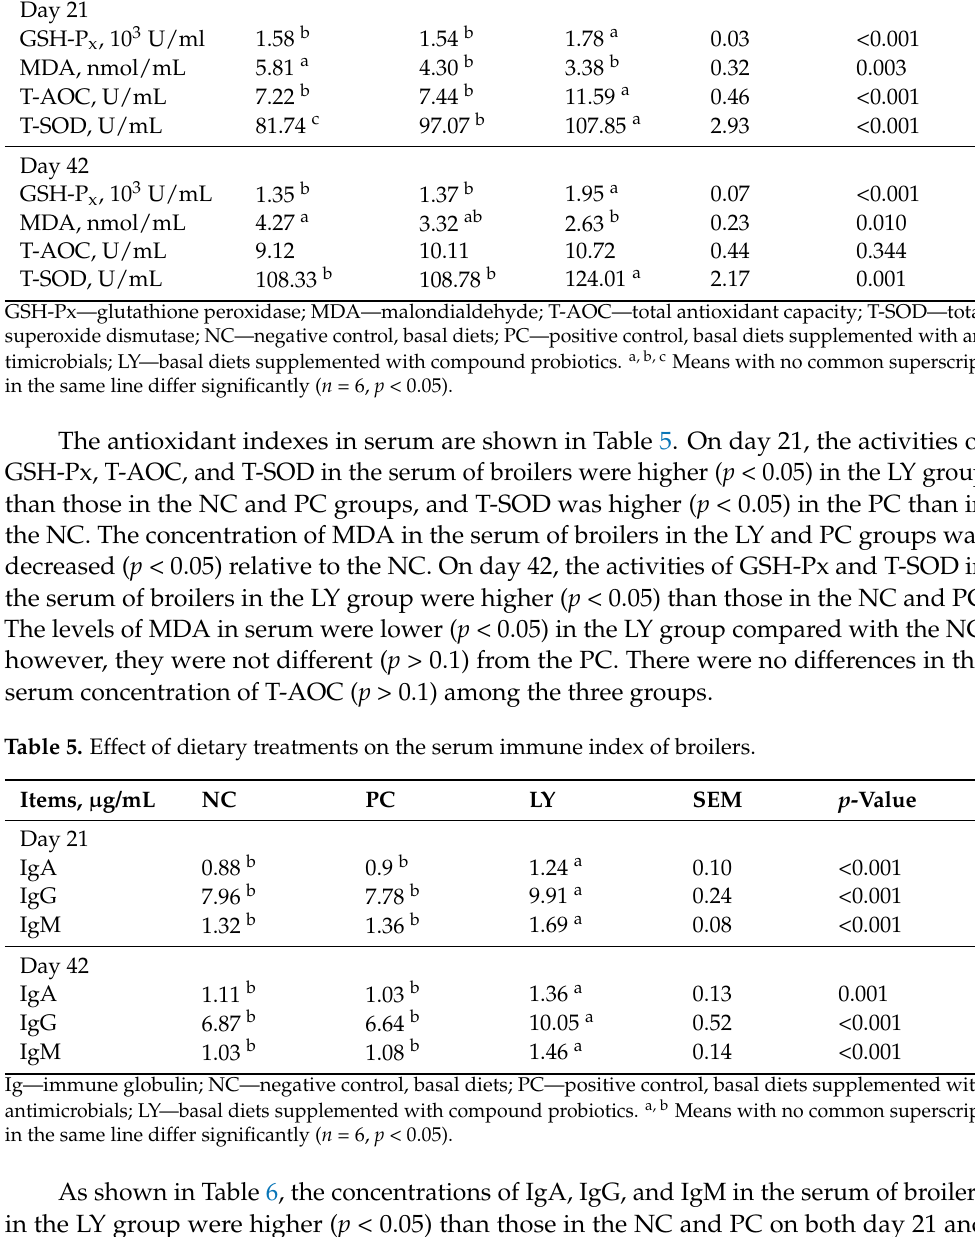
Table 4. Effect of dietary treatments on the serum antioxidant indexes of broilers. Items